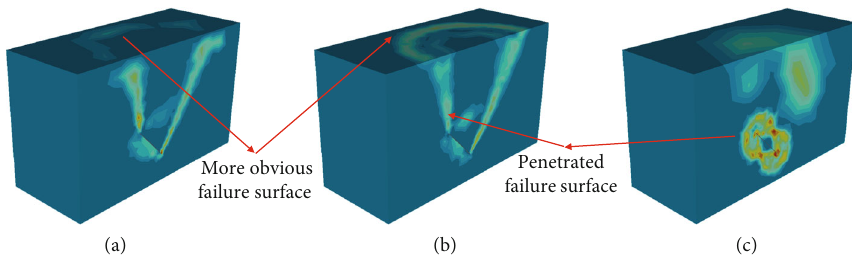
Figure 8: 3D-Failure of circular anchor plate in (a) loose sand, (b) normal soil, and (c) pure